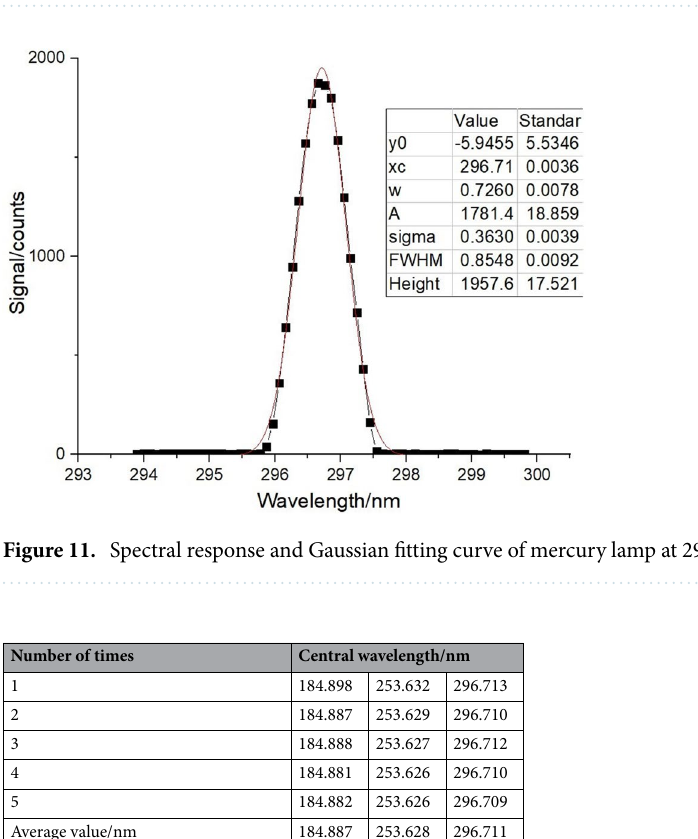
Figure 10. Spectral response and Gaussian fitting curve of mercury lamp at 253 nm.